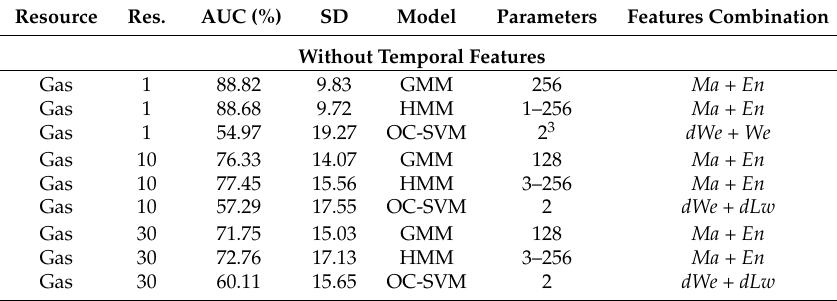
Table 3. Best results and corresponding features’ combination achieved for each resource and resolution ( Res. ) of the AMPds